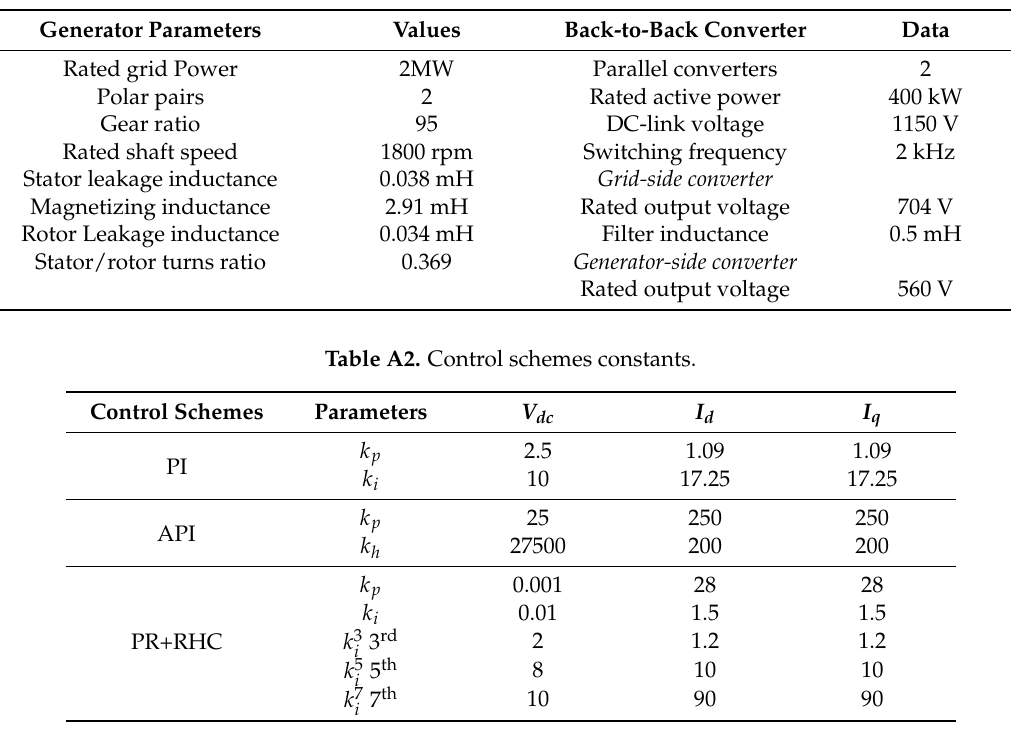
Table A1. Model nominal parameters.